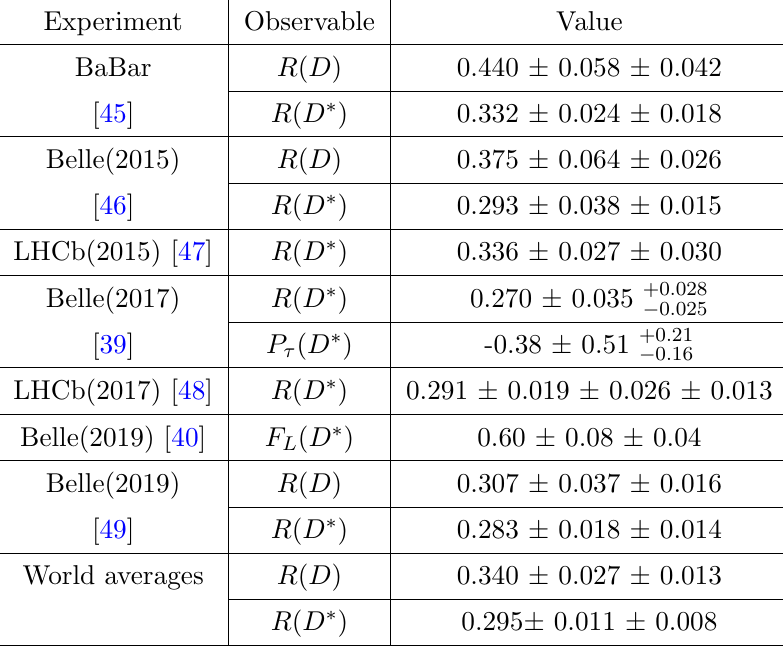
Table 7. Experiment inputs for R ( D ( (cid:3) ) ), P (cid:28) ( D (cid:3) ) and F L ( D (cid:3) ) used in the new physics (cid:12)ts.